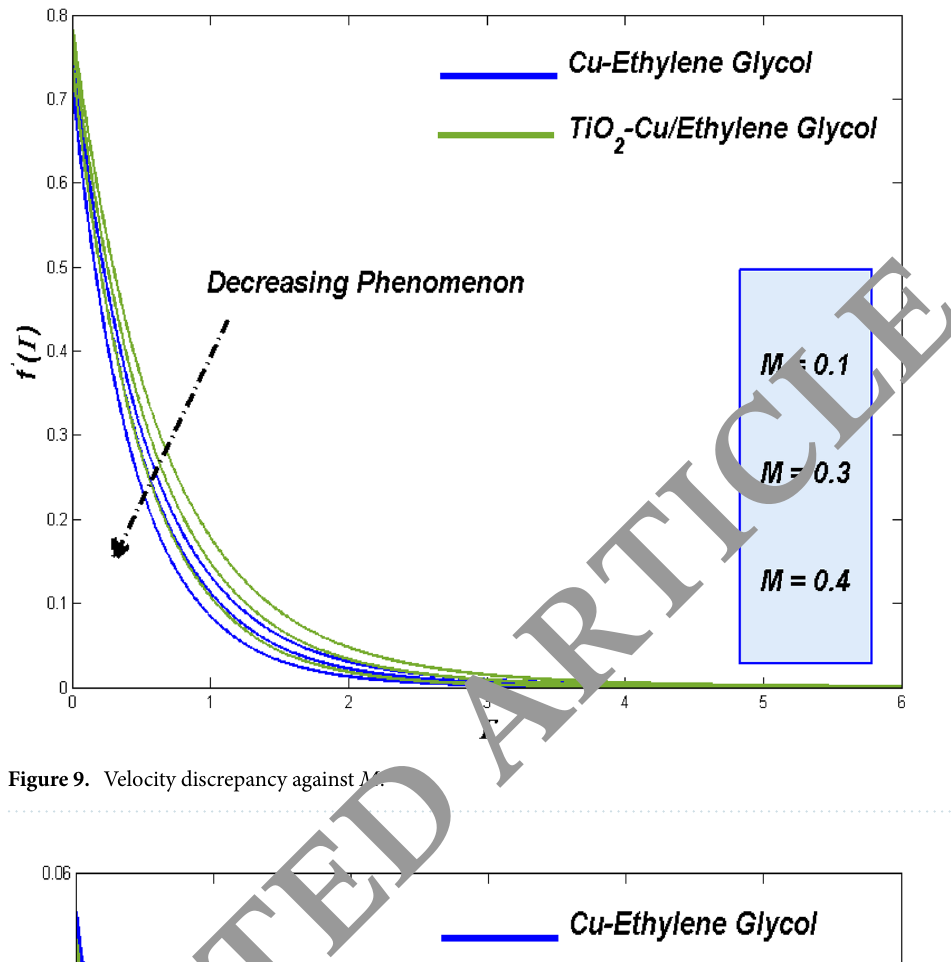
Figure 9. Velocity discrepancy against M .